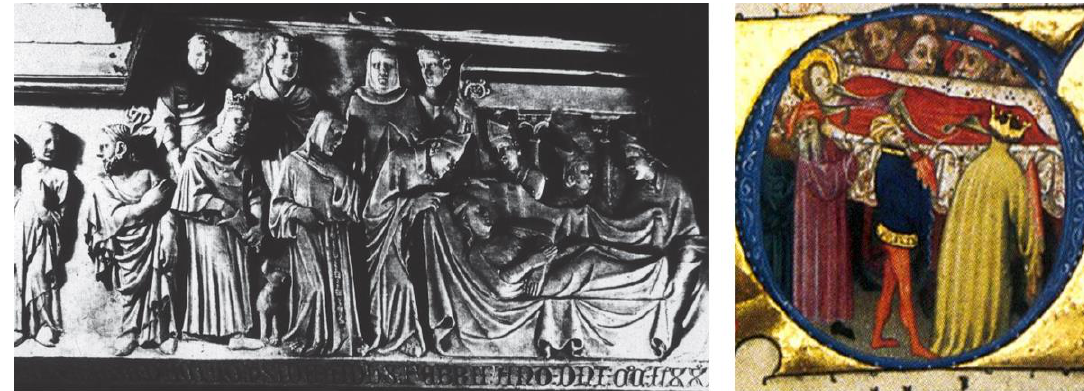
Figure 5. Santa Eulalia sarcophagus, detail. c. 1327. © Barcelona Cathedral, serie 28, n. 40; Misal de Santa Eulalia , Ms. 116, Barcelona, Arxiu Capitular ©. Fol. 308r. 1403. Published by Alturo, Llibre ma-nuscrit , p. 173.